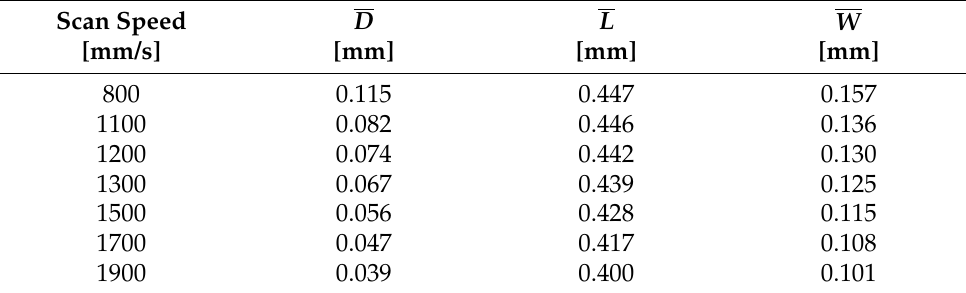
Table 2. Numerical results of the geometrical dimensions of the melt pool for different